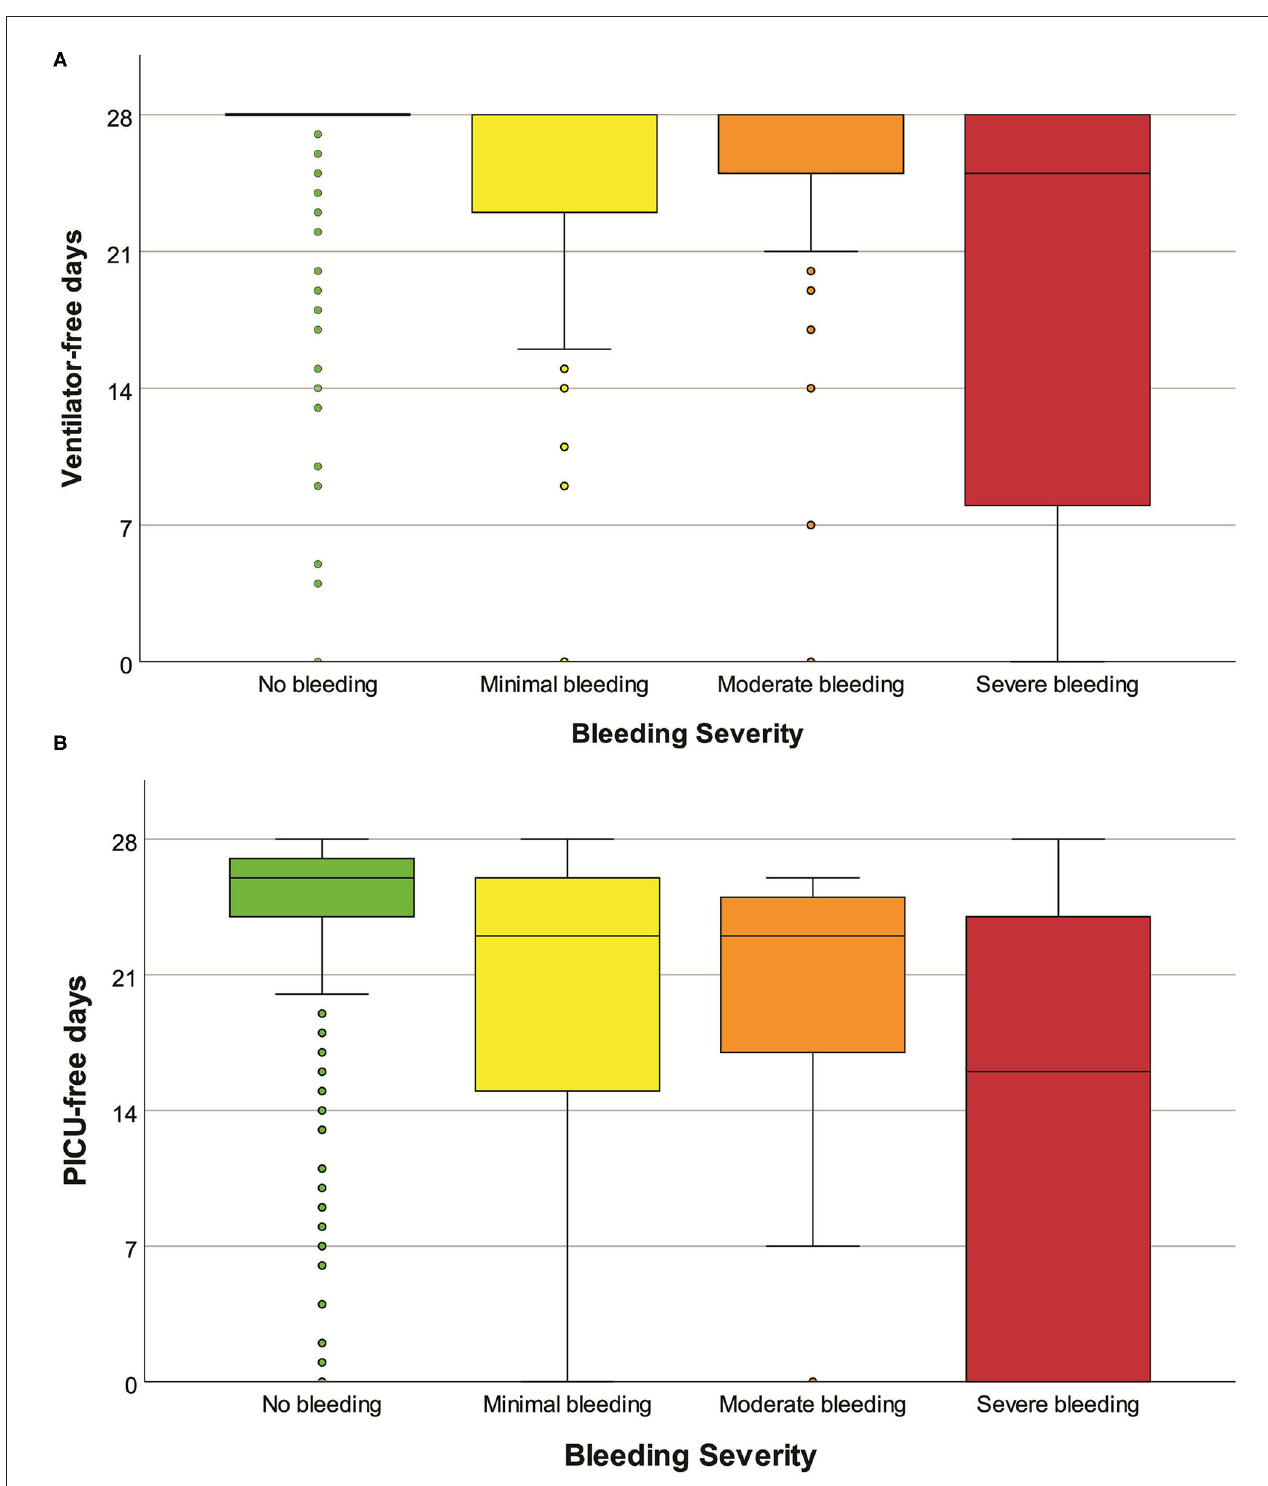
FIGURE 3 | Boxplot of ventilator-free days (A) and PICU-free days (B) , according to the severity of bleeding. Mild outliers ( < 1.5 IQR) and extreme outliers ( ≥ 1.5 IQR) are marked with circles and asterisks, respectively.